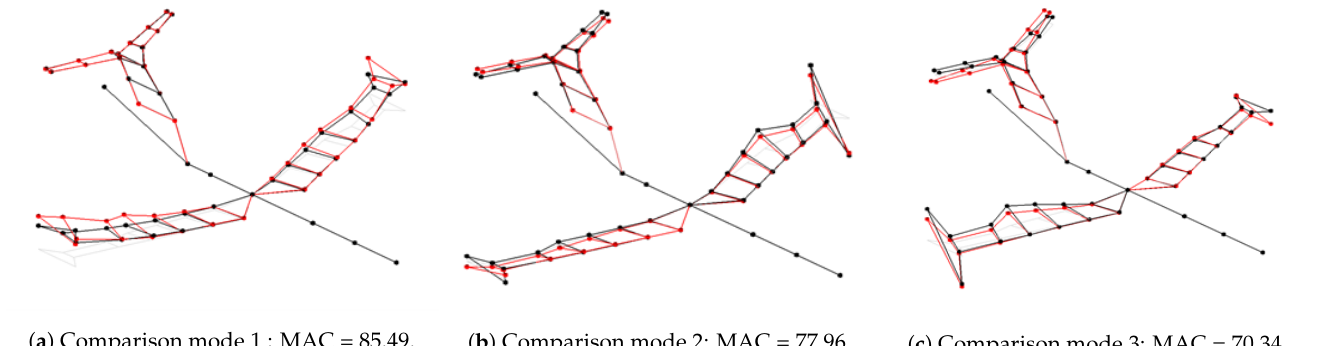
( a ) Comparison mode 1 : MAC = 85.49. ( b ) Comparison mode 2: MAC = 77.96. ( c ) Comparison mode 3: MAC = 70.34. Figure 6. Comparison between modal shapes: forward masses (black) and rear masses (red).